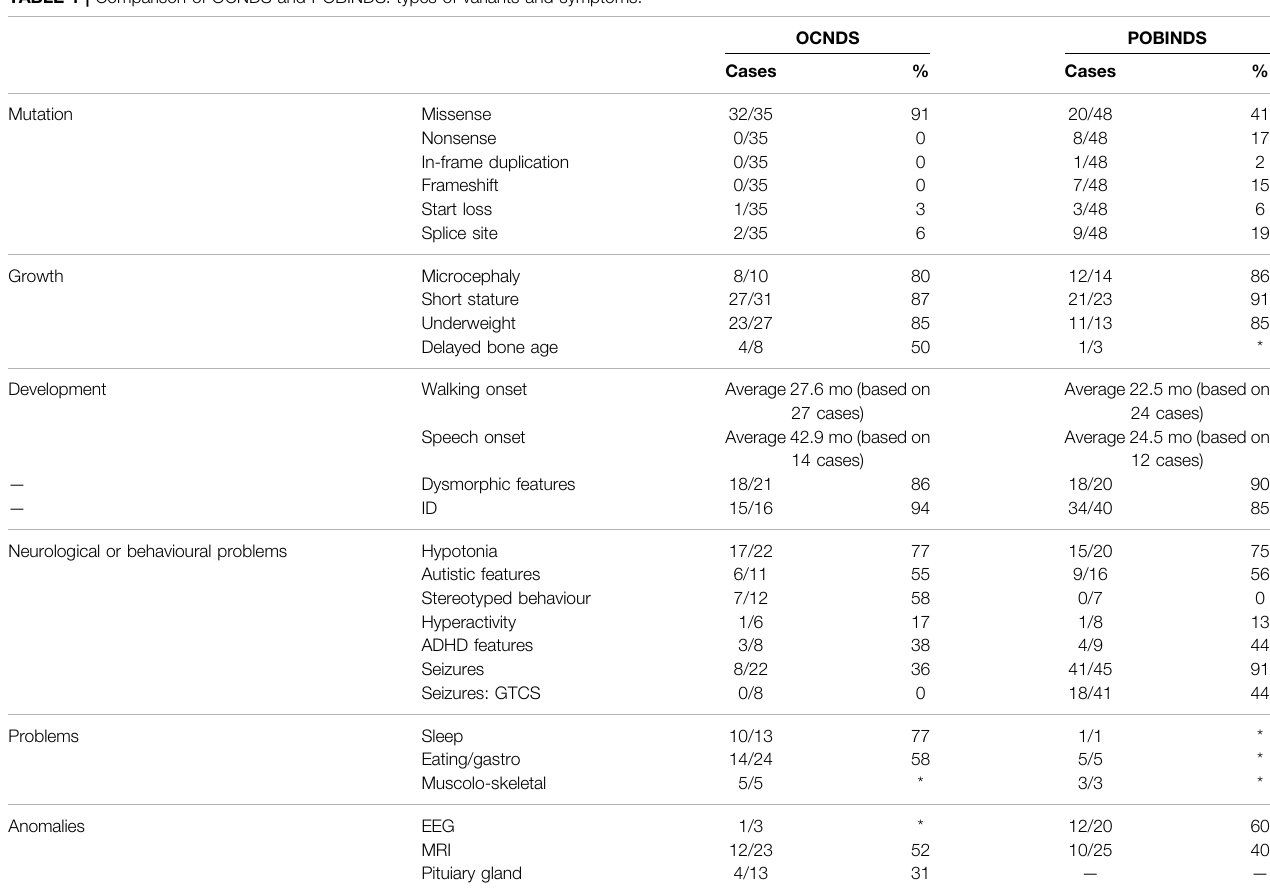
TABLE 1 | Comparison of OCNDS and POBINDS: types of variants and